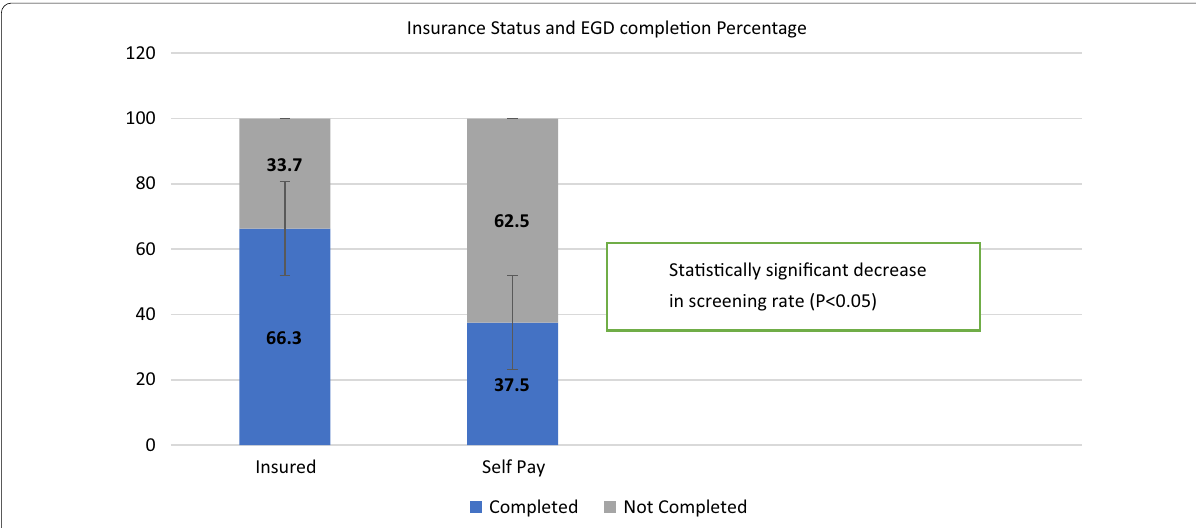
Fig. 4 Representation of number of individuals who completed their EGD screening as broken down by insurance status. There was a total of 111 study participants and 69 (62.2%) completed their EGD screening. Sixty-three (66.3%) of the insured participants and six (37.5%) of the self-pay participants completed their screening, this difference reached statistical significance ( p <